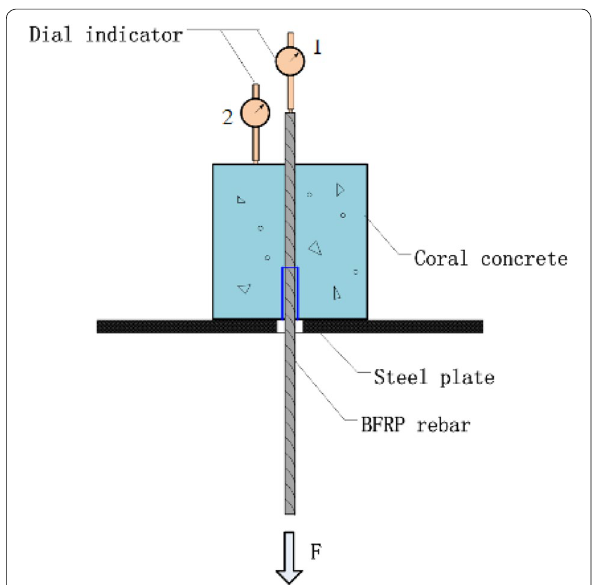
Fig. 5 The schematic diagram of pull-out test equipment.